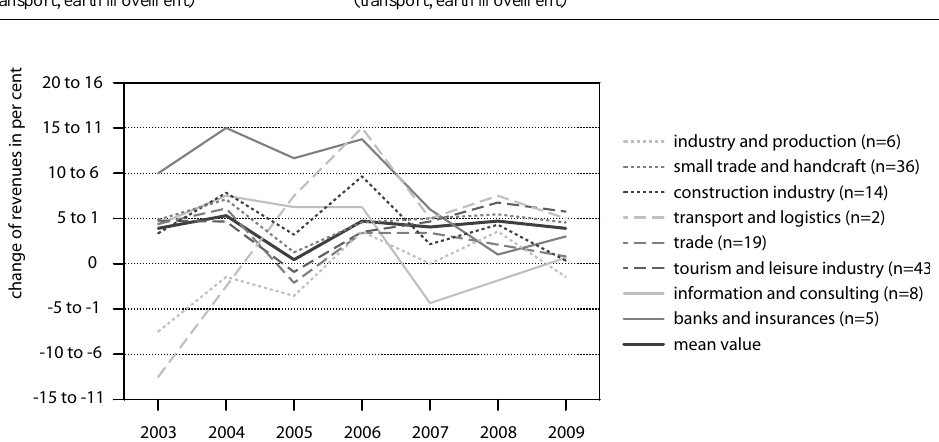
Fig. 6. Mean annual change of revenues from 2003 to 2009 based on companies’ estimates, n = 133 incl. multiple entries.